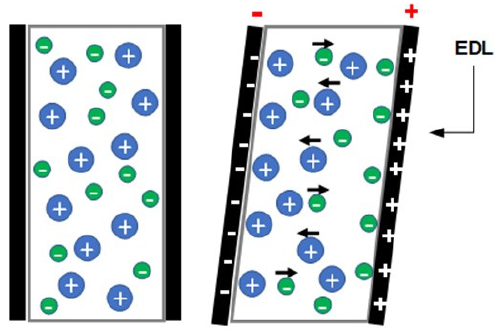
Figure 5. Illustration of EDL bending mechanism.